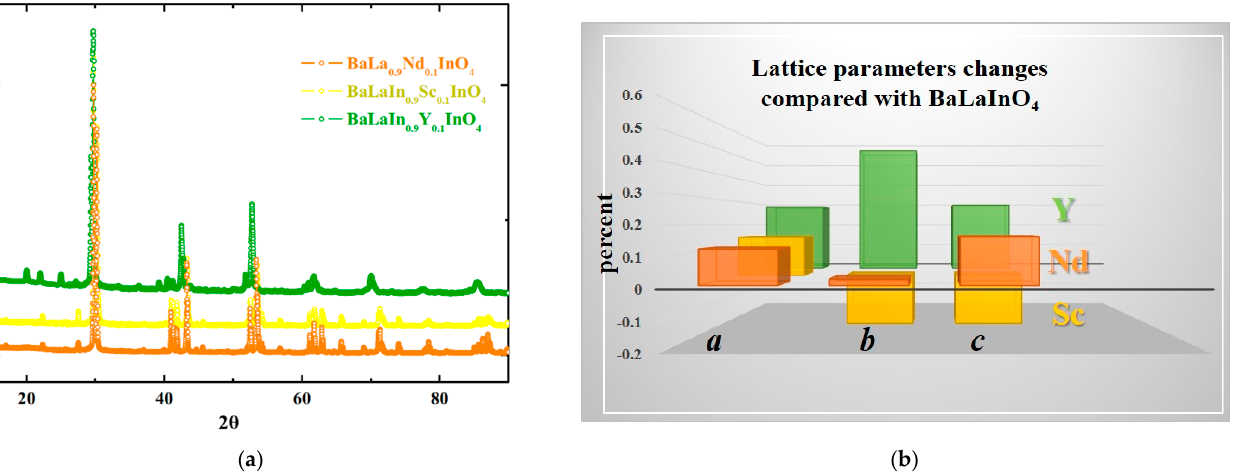
Table 2. The parameters of unit cell for the isovalent-doped compositions based on BaLaInO 4.